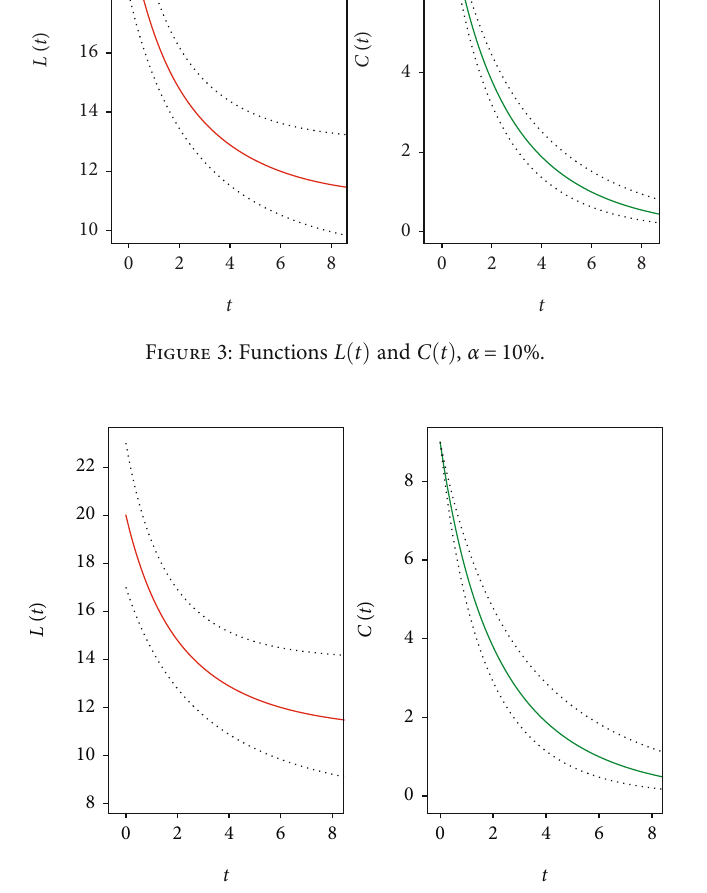
Figure 4: Functions L ð t Þ and C ð t Þ , α = 15 %